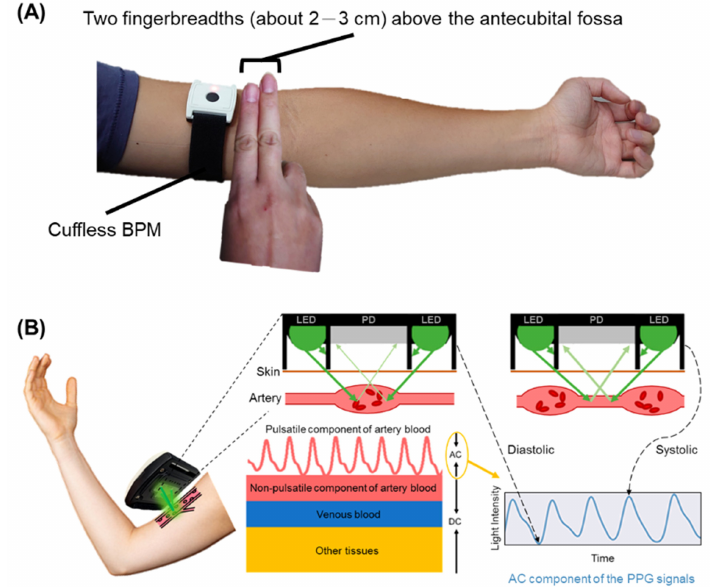
Figure 2. The optimal location for the cuffless BPM and theoretical basis of BP estimation from the reflective PPG signals. ( A ) The cuffless BPM could be located two fingerbreadths (about 2–3 cm) above the antecubital fossa by feeling the bicep tendon in the area of the antecubital fossa. ( B ) The schematic of the cuffless BPM device attached onto the upper-arm skin to acquire reflective PPG signals. The acquired PPG signals comprised an AC (pulsatile) and a DC (slowly varying) component. The AC component was attributed to changes in the blood volume synchronous with each heartbeat, whereas the DC component was related to respiration, tissues, and average blood volume. The corresponding working principle of the reflective PPG sensor involved capturing the AC component of the PPG signals, which defined approximate features, such as DBP, represented by valleys, and SBP, represented by peaks.